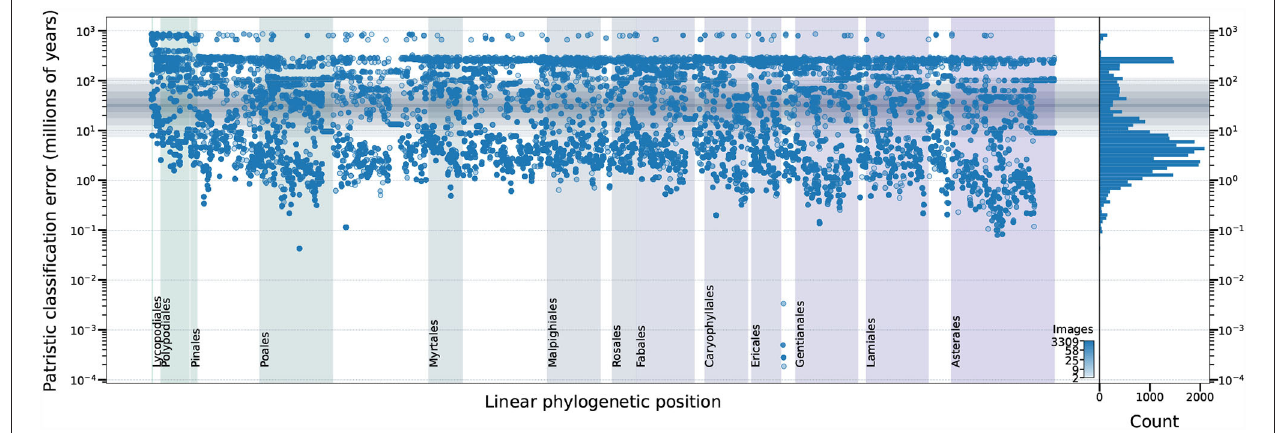
FIGURE 9 | The relationship among dataset properties and incorrect model predictions for the top performing model. The phylogenetic relationship among the expected taxa (x–axis) is represented by the right ladderized phylogenetic tree for all genera in the dataset (Jin and Qian, 2019). The y–axis indicates the identification error—expressed as patristic distance between the expected and predicted classifications. The number of training images for each expected taxon is indicated by marker color and visualized as a histogram in the right panel. The median patristic distance between sister genera is represented by a solid horizontal gray line with gray boxes indicating the 10–90, 20–80, 30–70, and 40–60 decile ranges. The top ten angiosperm, top gymnosperm, top fern, and top lycophyte orders, as measured by the number of training images, are labeled. Results for 628 of 243,020 (0.26%) test images are not displayed because those taxa could not be located in the reference phylogenetic tree (Jin and Qian, 2019).